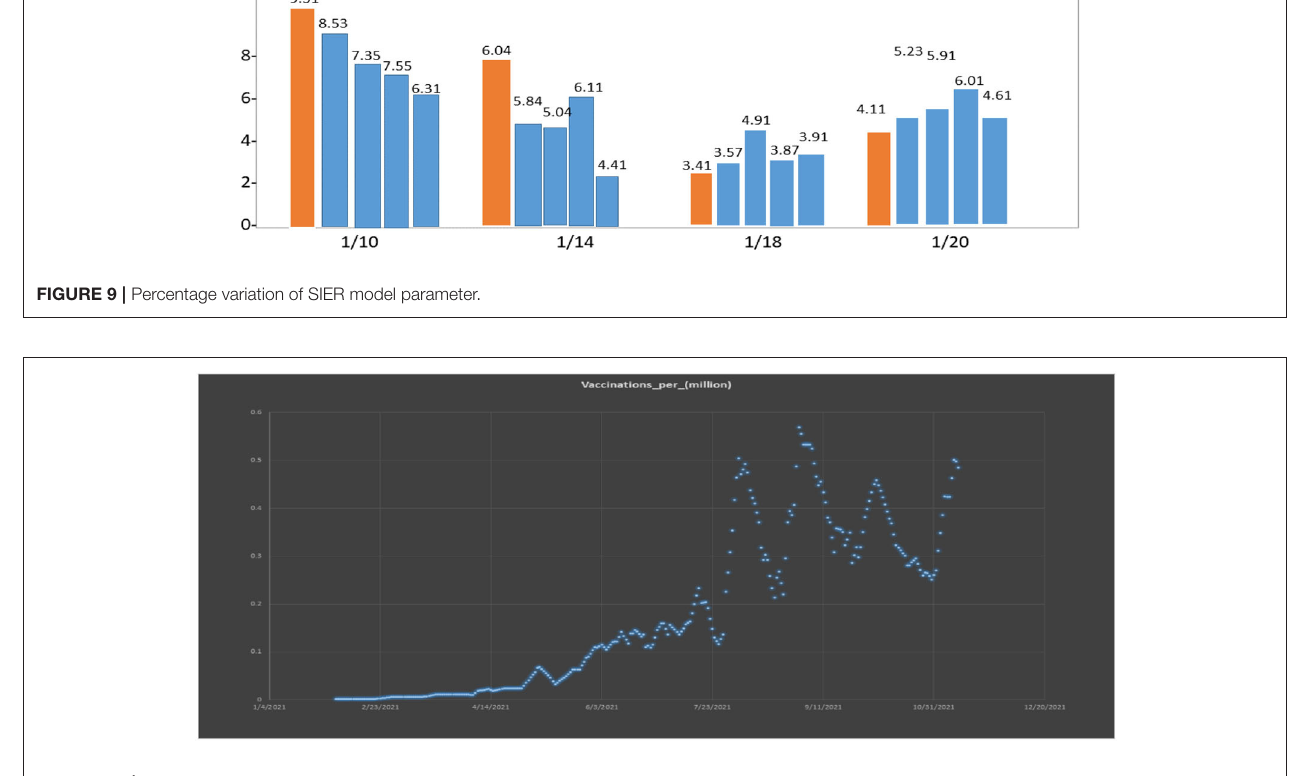
FIGURE 10 | Graphical presentation of the vaccination per million.